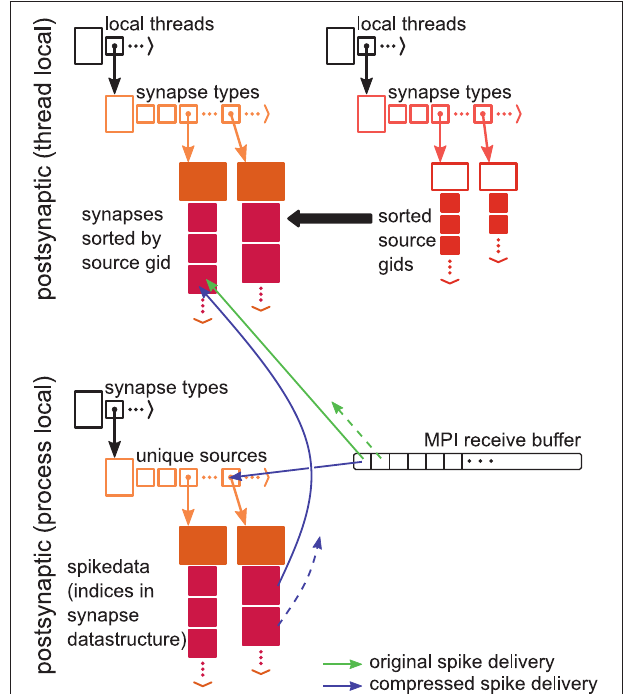
FIGURE 7 | Spike compression adds an additional indirection to post-synaptic spike routing. Green arrow denotes original spike delivery introduced with the 5g kernel (Jordan et al., 2018, same display as their Figure 4A ). Blue arrow illustrates additional indirection with compressed spike delivery. Dashed arrows indicate spikes from the same source neuron with target on a different